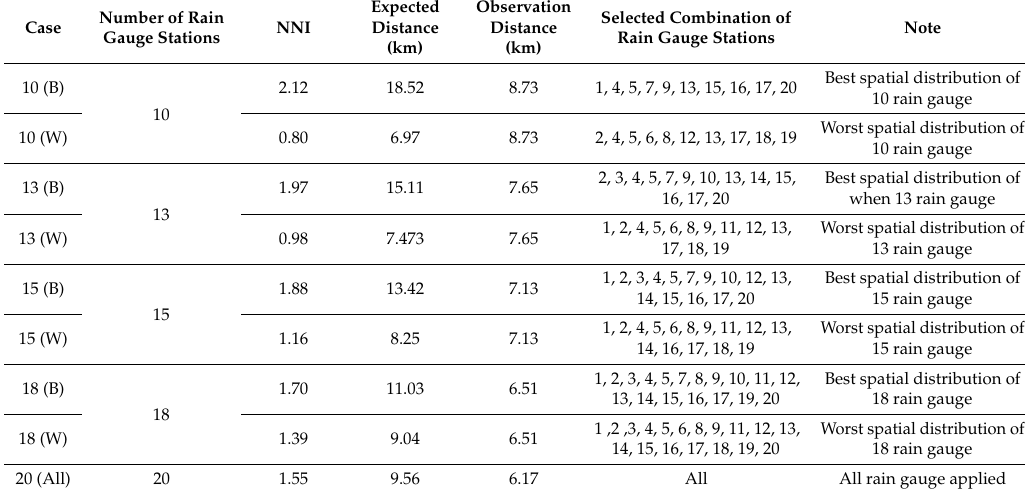
Table 9. Spatial distribution Depending on the Number of Rain Gauge Stations.